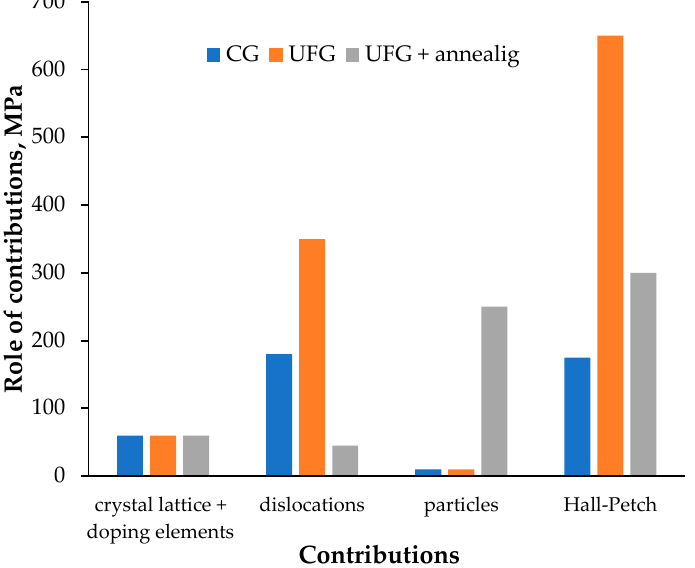
Figure 16. Contributions of microstructure parameters to yield strength in CG and UFG steel. Macroelasticity stress and yield strength for UFG steels after N = 4 ECAP cycles were 410–425 MPa and 1070–1145 MPa, respectively. Since σ PN , σ c , and σ p contributions